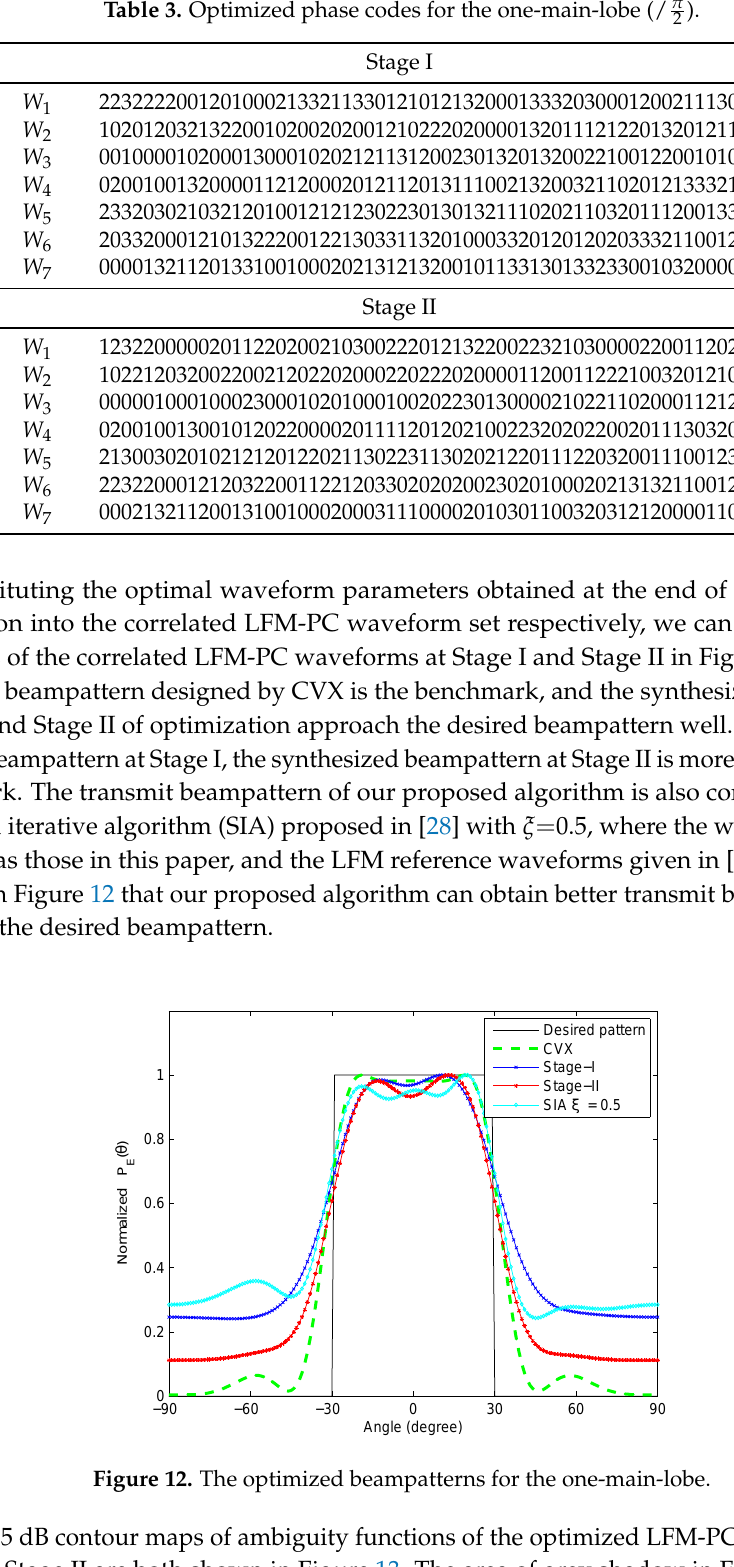
Table 3. Optimized phase codes for the one-main-lobe (/ π